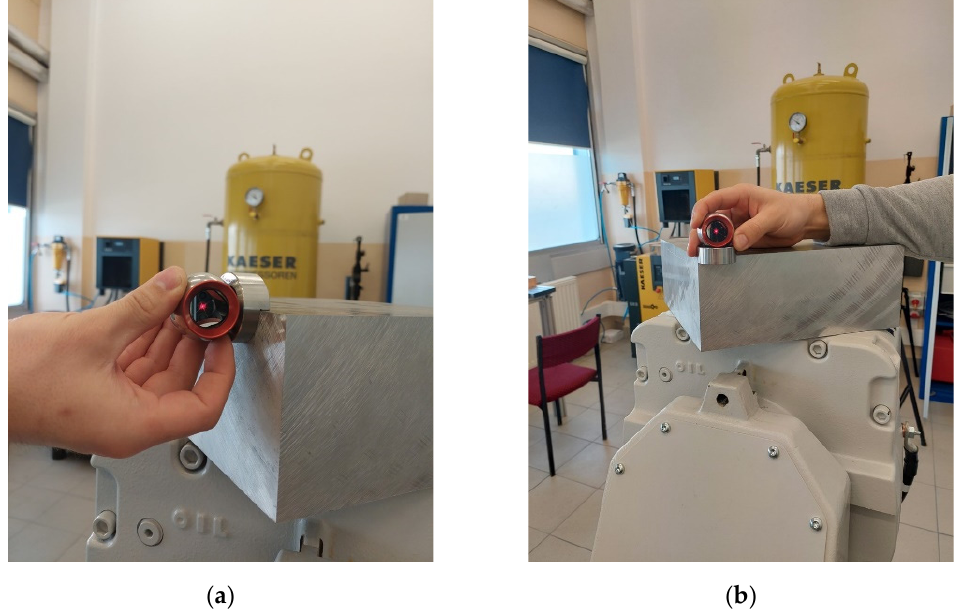
Figure 19. Determining the point using a retroreflector: ( a ) determining point 1; ( b ) determining point 2.